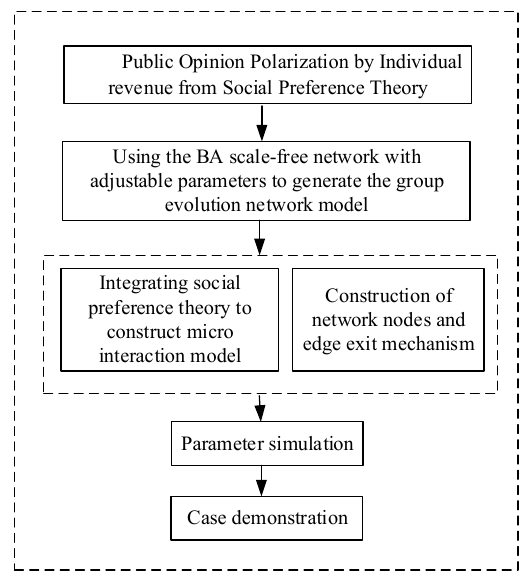
Figure 1. Research framework in this paper.